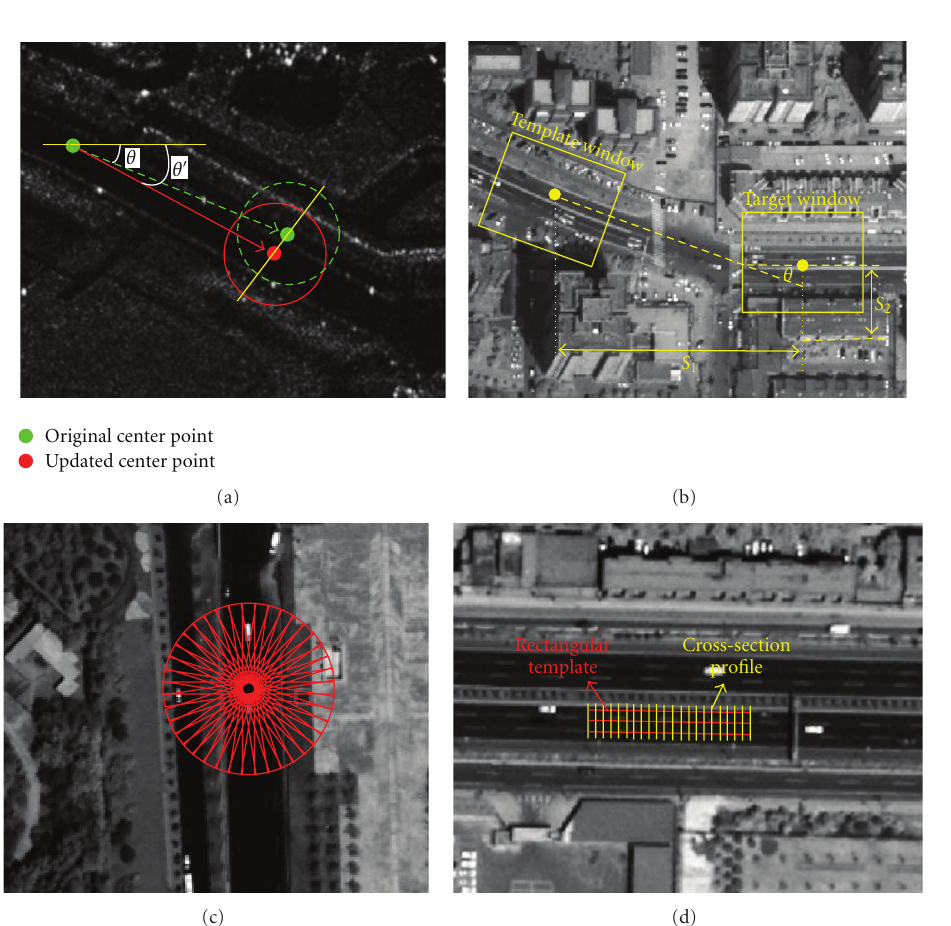
Figure 3: Local detection window. (a) Circle window. (b) Rectangular window. (c) Rotating rectangular window. (d) Interlaced